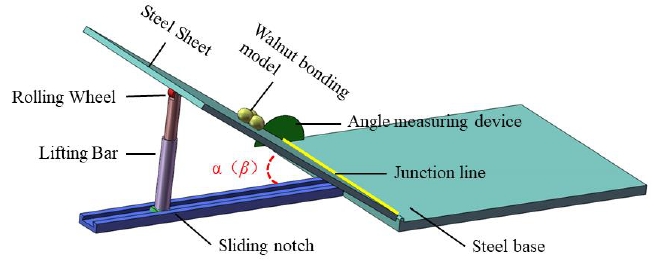
Figure 5. Measurement test of the walnut – steel plate static friction coefficient.